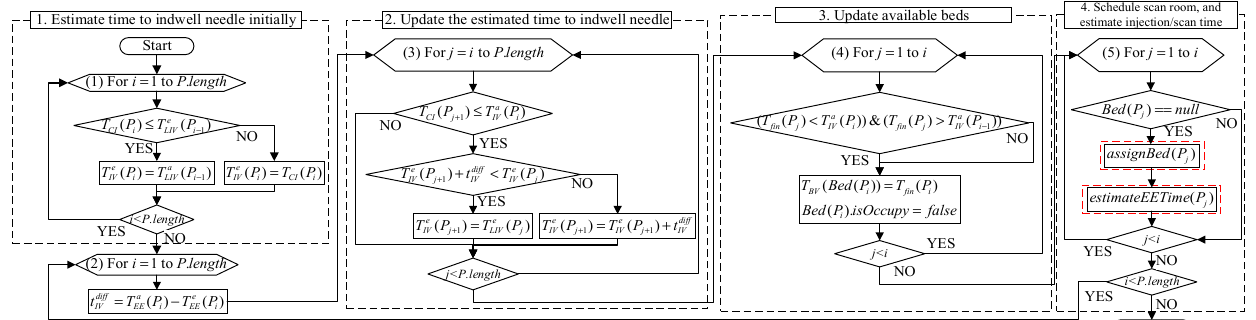
Figure 15. Total queue list interface.